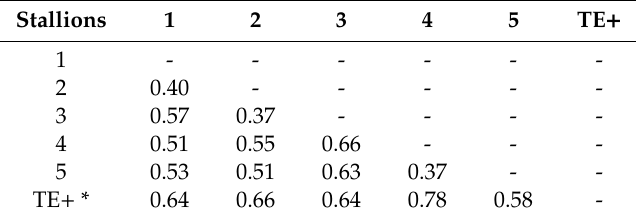
Table 1. Bray-Curtis dissimilarity indexes for the first batch.